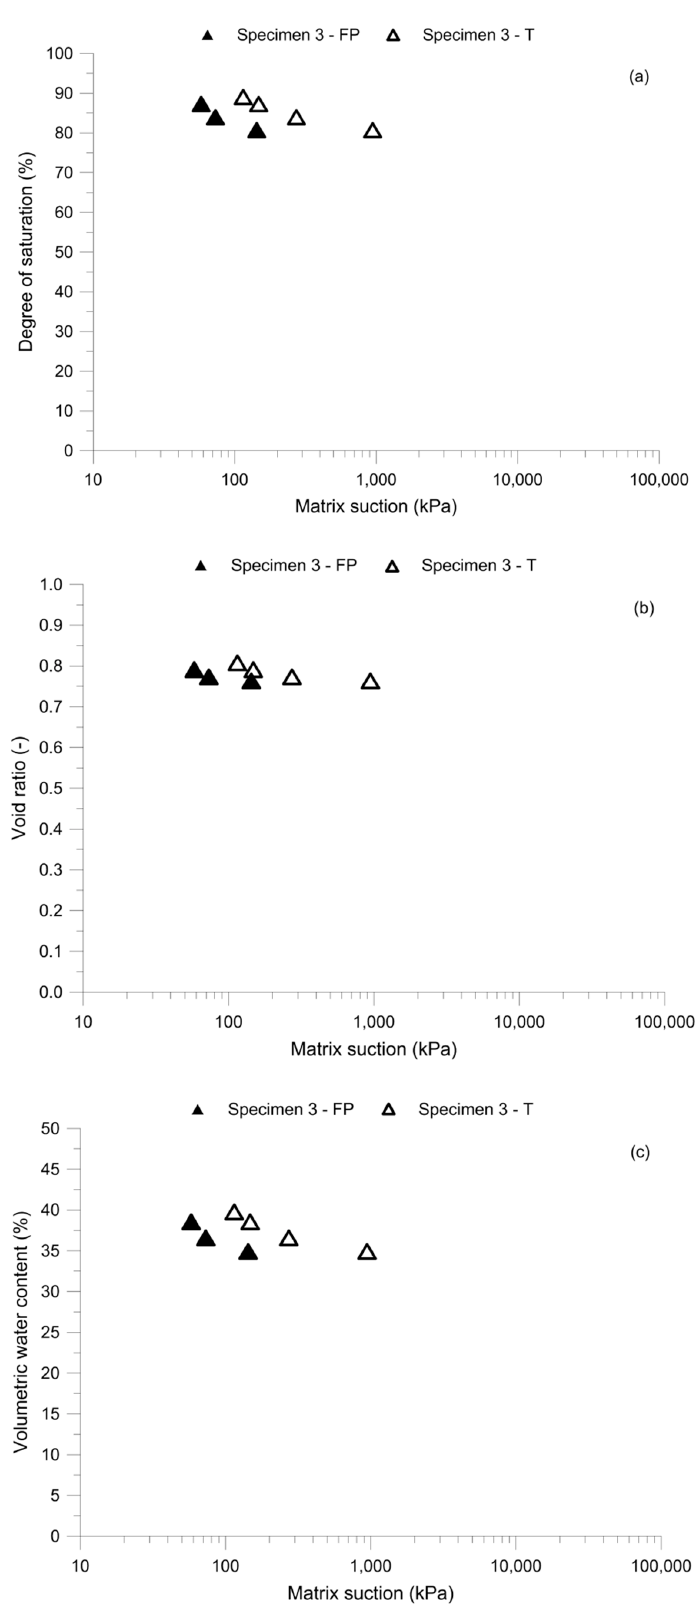
Figure 7. Water retention data of a specimen (tested with both the filter paper technique, FP, and high-capacity tensiometers, T) reported in terms of matrix suction against: ( a ) degree of saturation; ( b ) void ratio; ( c ) volumetric water